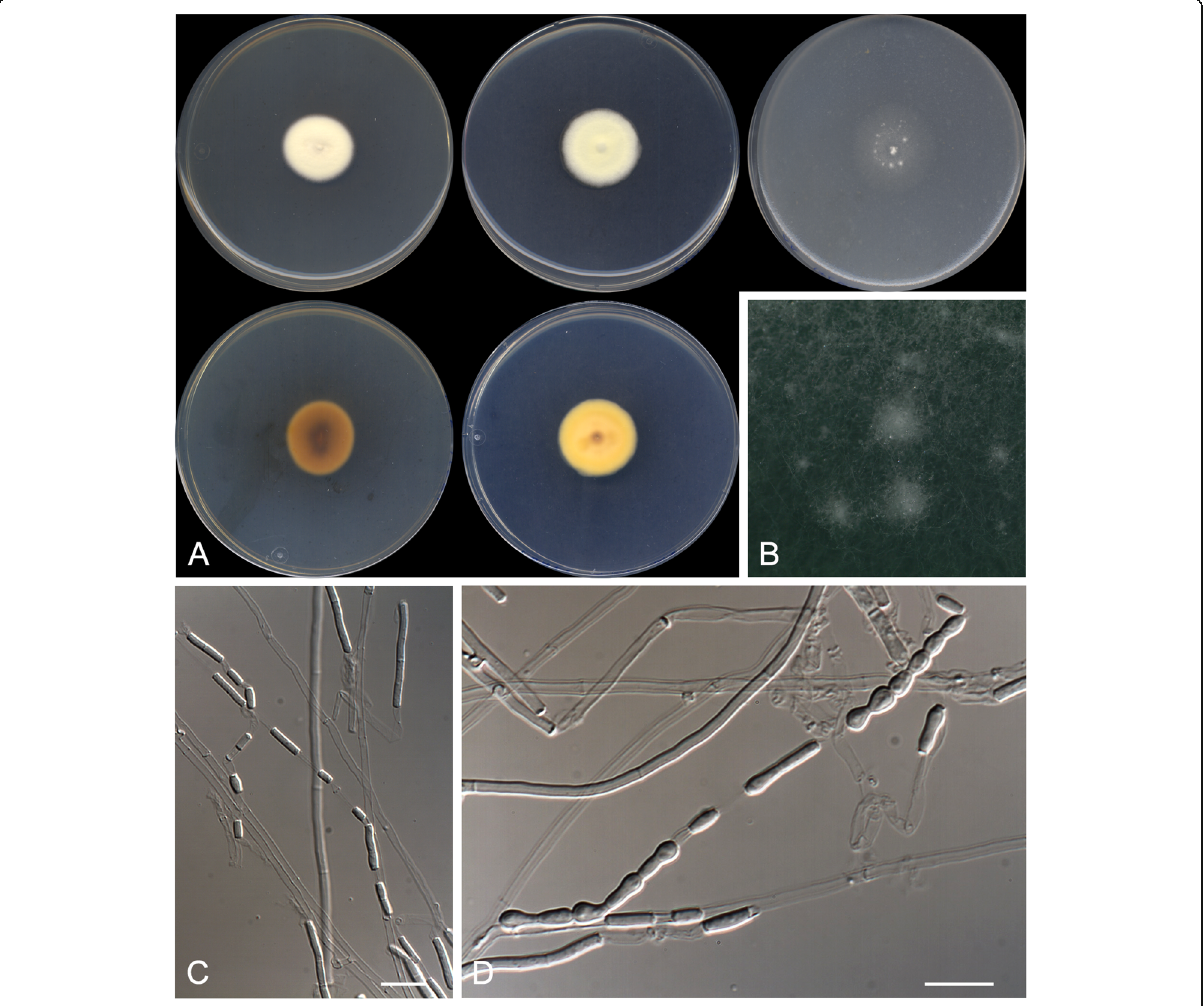
Fig. 10 Pseudomalbranchea gemmata CBS 146933 T . a Colonies on PYE, PDA and OA after 14 d at 25 °C, from left to right (top row, surface; bottom row, reverse). b Detail of the colony on OA. c – d Large, intercalary, irregularly-shaped arthroconidia disposed singly or in chains along the fertile hyphae. Scale bar = 10 μ